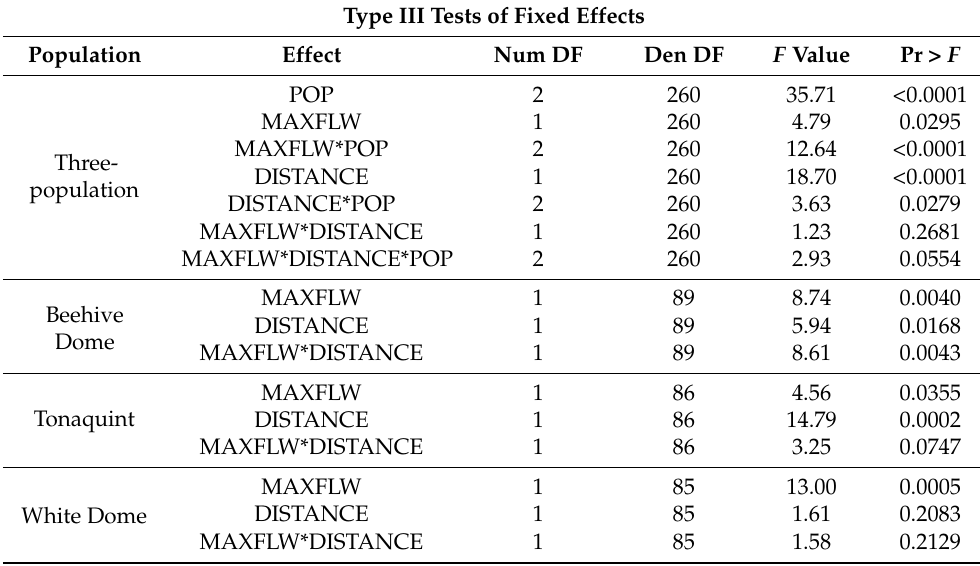
Table A20. The effect of maximum flower number and interplant distance on filled seed proportion across three populations in 2019 and for these three populations analyzed separately.